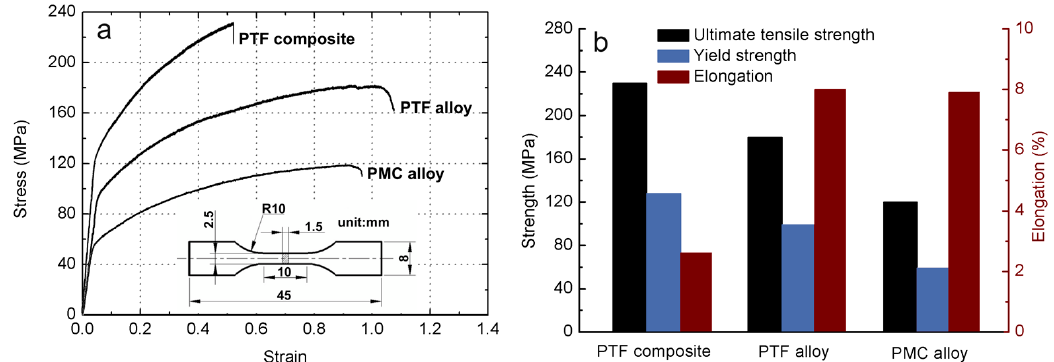
Figure 5. Tensile properties of these three materials: ( a ) stress-strain curves; ( b ) statistical results based on the average of minimum five tests.